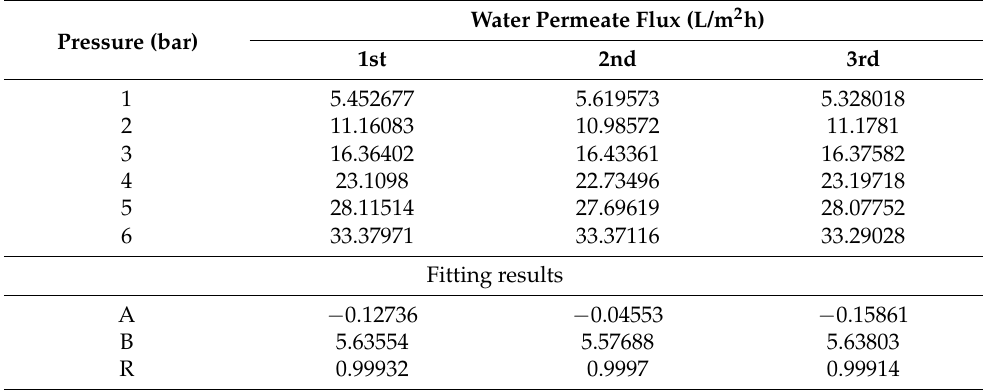
Table 1. Fitting results of water contact angle ( ◦ ) versus time using linear function for three Al 2 O 3 HF supports and TiO 2 /GO-Al 2 O 3 HF NF